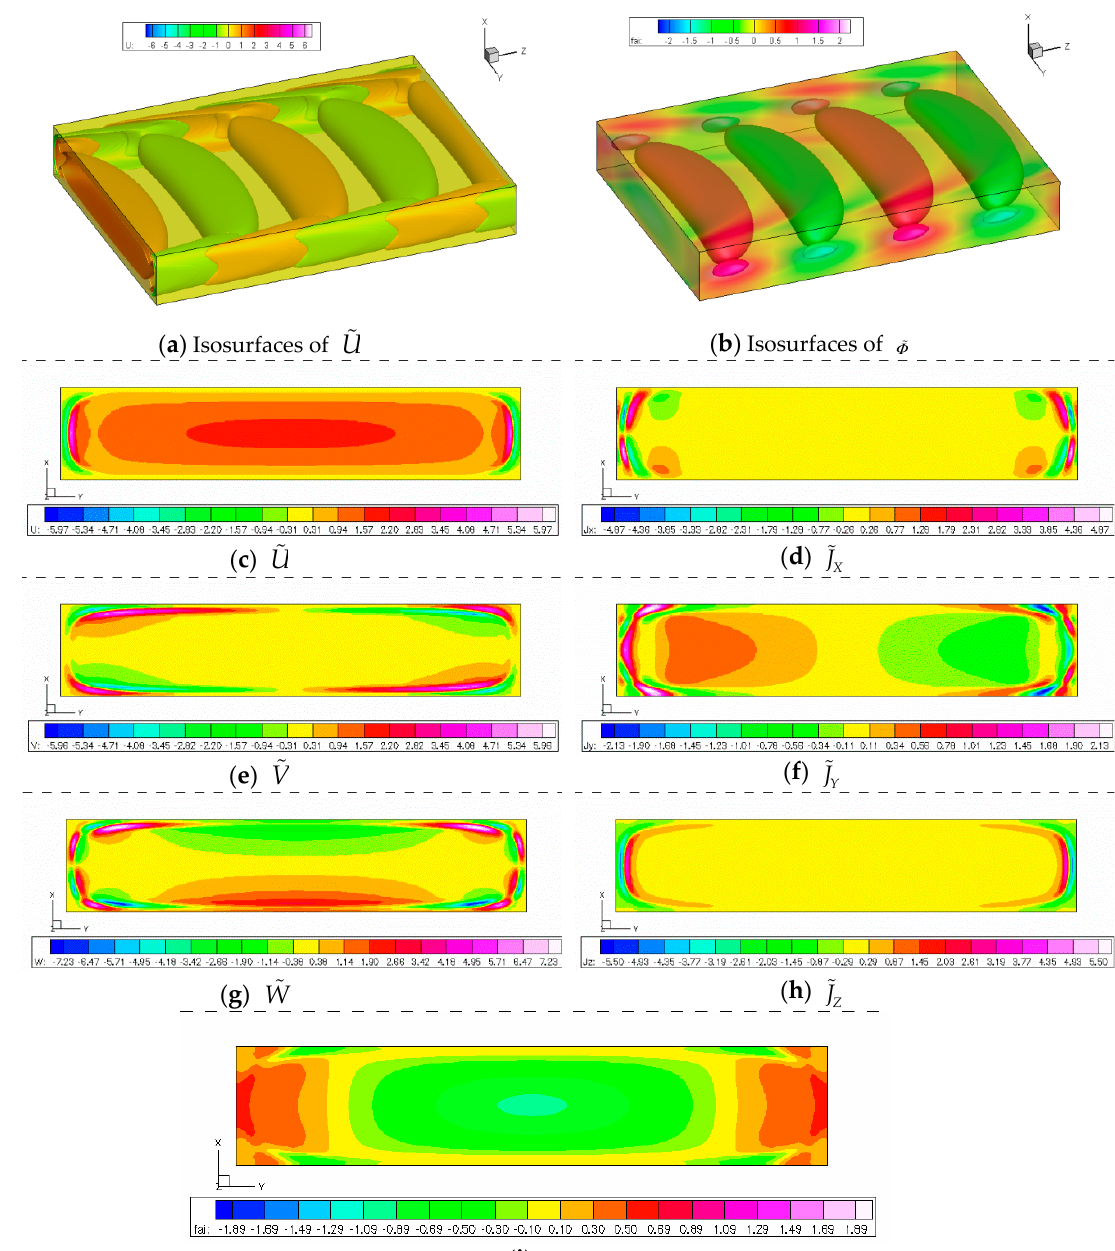
 J ; ( e ) contour map of X contour map of Φ  .